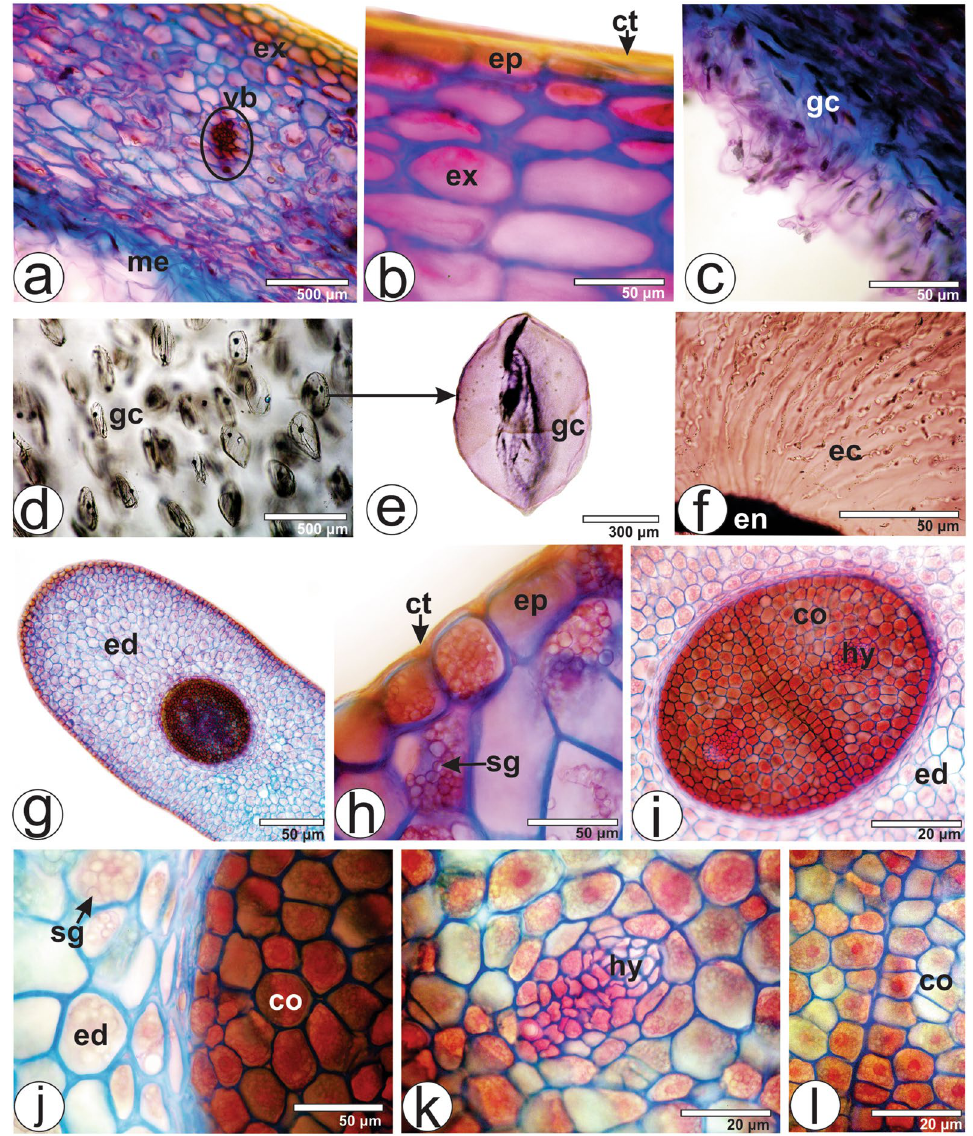
exocarp, gc globular cells, hy hypocotyl, me mesocarp, sg starch grain, vb vascular